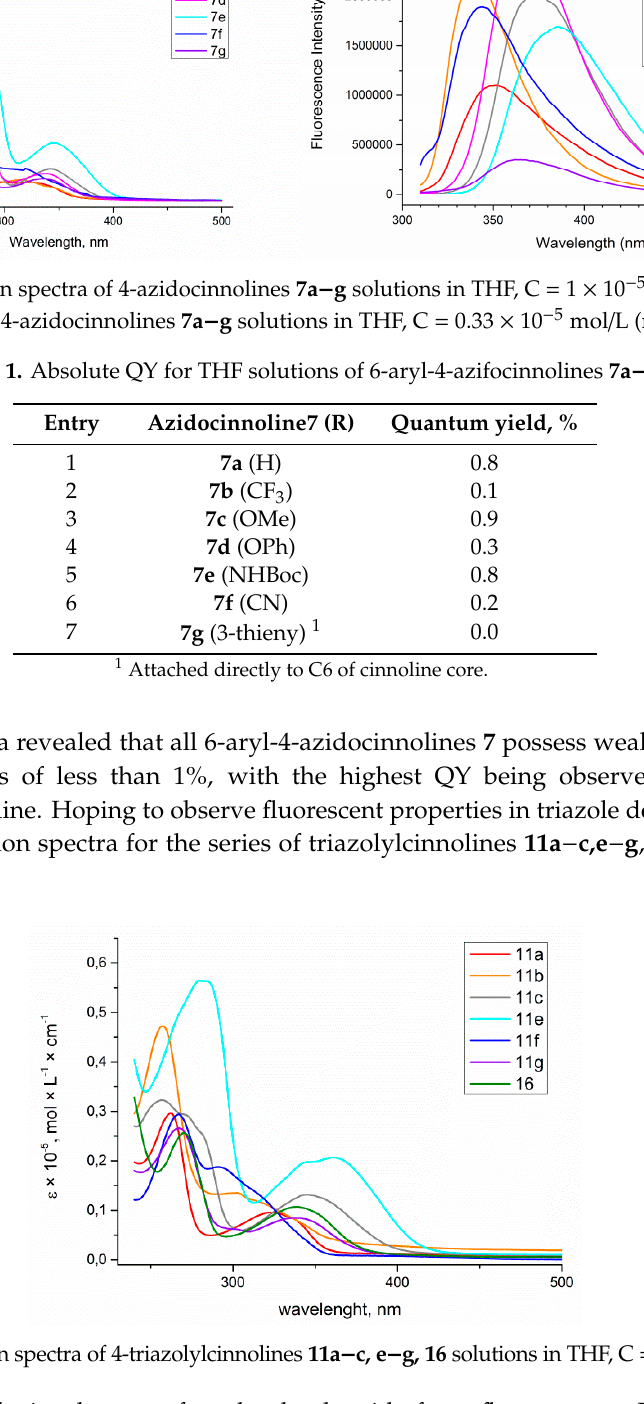
Figure 4. Absorption spectra of 4-triazolylcinnolines 11a − c, e − g, 16 solutions in THF, C = 1 × 10 − 5 mol/L.